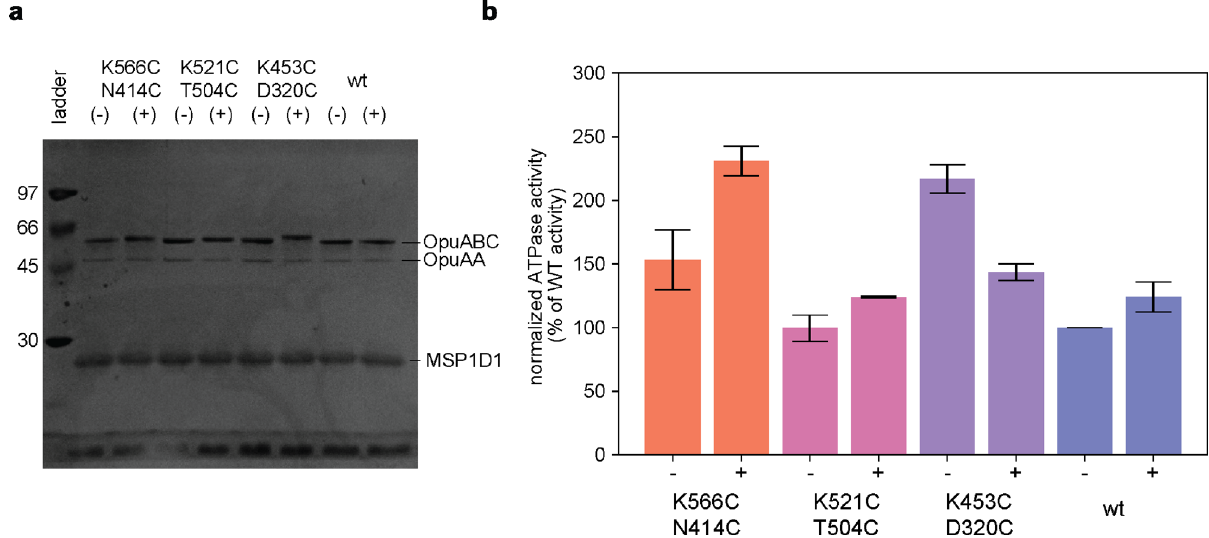
Figure 4. SBD mutations in the full-length transporter ( a ) SDS-PAGE gel showing OpuA nanodiscs of the three mutants and wild-type OpuA before (−) and after (+) labeling with AMdiS (4-acetamido-4 ′ - maleimidylstilbene-2,2 ′ - disulfonic acid) ( b ) Normalized ATPase activity in the presence of 10 mM MgATP, 62 μM glycine betaine and 300 mM KCl of the same nanodiscs as shown in ( a ). The ATPase activity was corrected for the A 280 absorbance of the nanodiscs (contribution from the OpuA subunits and the MSP1D1 scaffolding protein) and normalized against the activity of unlabeled wild-type OpuA. Datapoints are shown as the average of two technical replicates. Error bars represent the standard